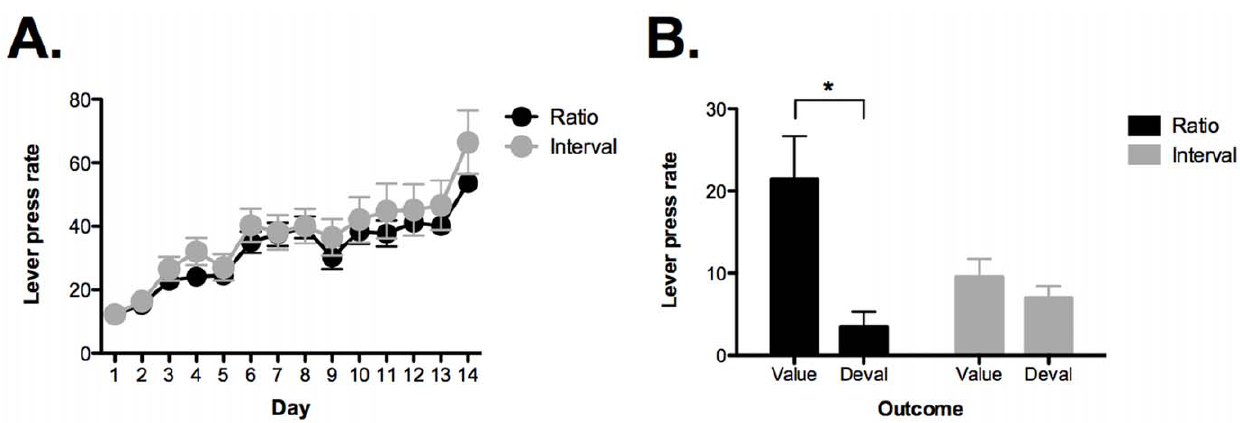
Figure 1. Interval training leads to habitual responding. A) Mice were trained to lever press for food pellets across 14 days. On days 1–2 the ratio group was trained on a RR5 schedule while the interval group was trained on a RI15 schedule. On days 3–4 the ratio group was trained on a RR10 schedule while the interval group was trained on a RI30 schedule. On days 5–14 the ratio group was trained on a RR20 schedule while the interval group was trained on a RI60 schedule. Both groups showed an increase in responding across training days. B) Mice trained on RR schedules showed a selective reduction in responding on the lever leading to the devalued outcome indicating that behavior was goal-directed. Mice trained on RI schedule did not exhibit a selective reduction in responding indicating that behavior was habitual. Error bars represent 6 SEM. *p ,